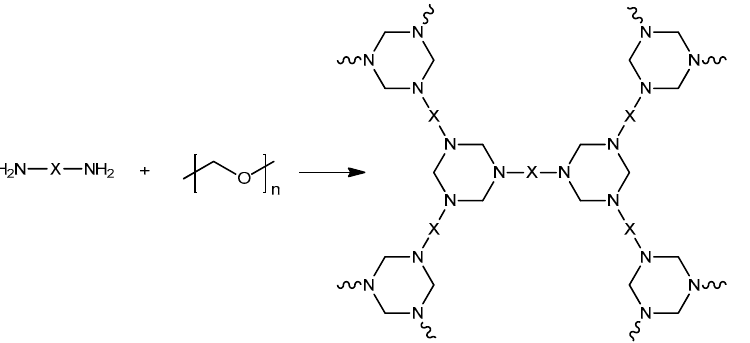
Figure 1. Possible side reaction during the production of benzoxazine monomers based on diamines.